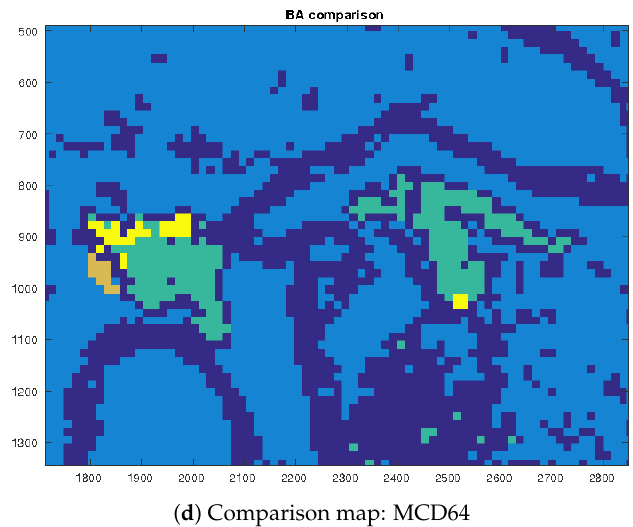
Figure 6. Figure shows an example of errors of omission based on Landsat-based validation maps. The top row shows before and after false color composites (using bands 7,4,2) of a region with detected burned area (WRS path-233, WRS row-068, MODIS tile name-h11v10, year 2010). The bottom row shows the burned area detected by RAPT and MCD64 relative to Landsat-based ground truth generated using the BAMS scheme. Each comparative image is color coded as yellow for true positives, orange for false positives, green for false negatives and light blue for true negatives. Masked regions (due to detectable cloud cover or non-forest landcovers) are colored dark blue in the comparative images. Note that the region shown has 900 × 1200 Landsat